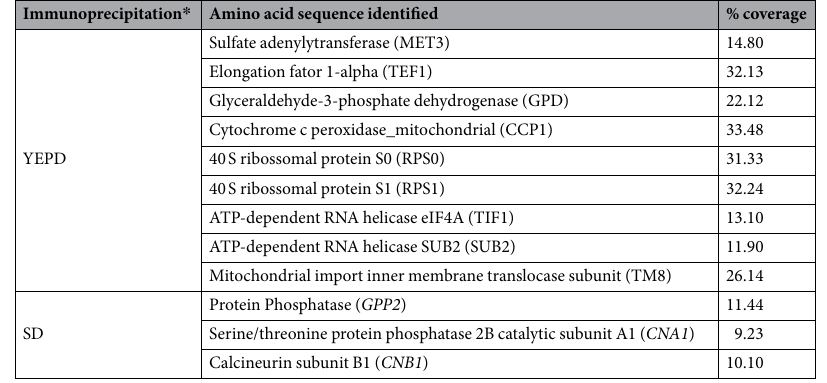
Table 1. Proteins identified by LC/MS and MALDI/TOF after IP of GFP-Cys3. CNU080 cell extracts were collected in two growth conditions (2 h in YEPD and